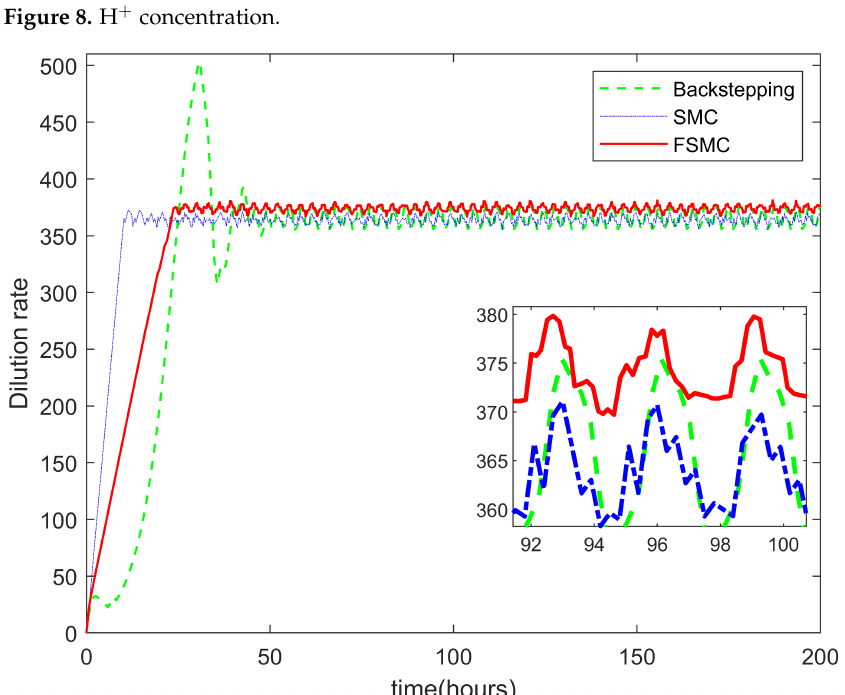
Figure 8. H + concentration.